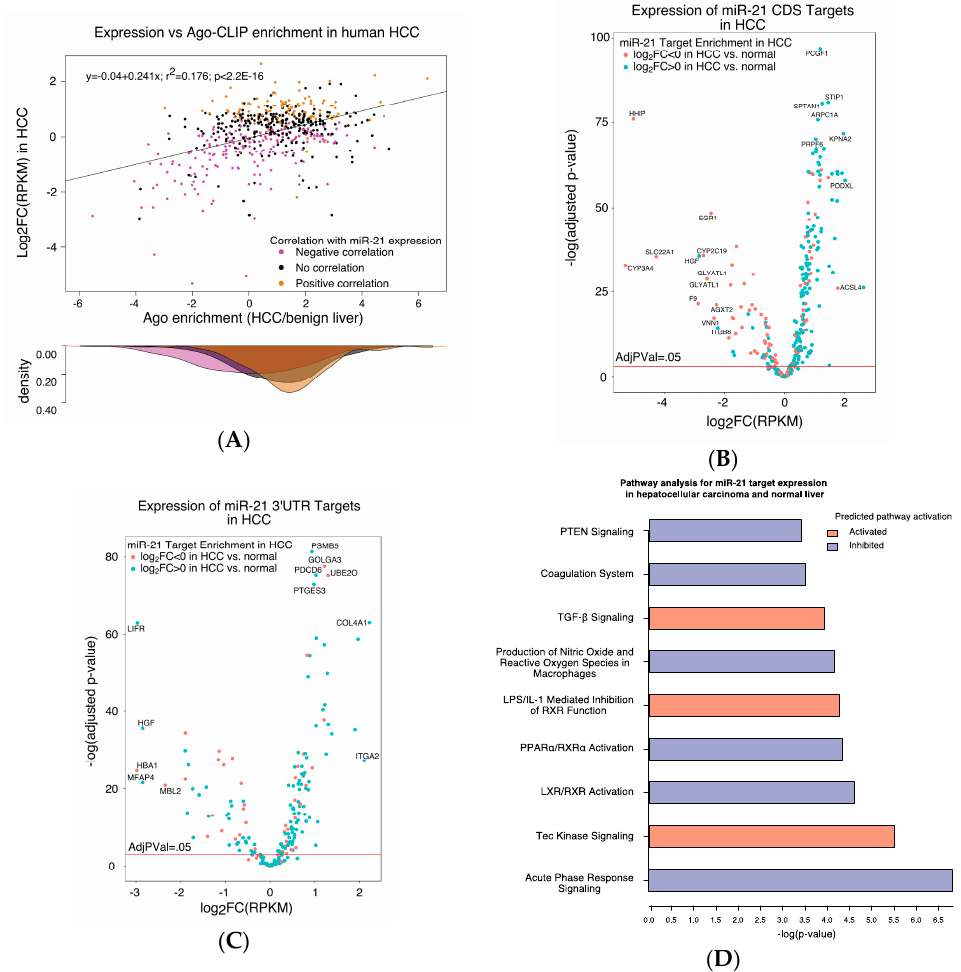
Figure 4. The expression data of the miR-21 interactome in tumor ( n = 377) and matched normal tissue ( n = 59) in patients with liver cancer were extracted from TCGA and compared to the tumor enrichment score determined by Ago-CLIP ( A ). Log 2 -fold enrichment of miR-21 targets by Ago-CLIP in HCC positively correlated with log 2 -fold expression change in tumor ( p < 2.2 × 10 − 16 ). Genes whose expression in tumors negatively correlated with miR-21 expression were less enriched in HCC by Ago-CLIP than those with positive correlation ( p < 2.2 × 10 − 16 ). Among miR-21 CDS targets, 64 genes were significantly downregulated and 173 genes were significantly upregulated ( B ). Among miR-21 3’UTR targets, 48 genes were significantly downregulated and 173 genes were significantly upregulated ( C ). Expression data for miR-21 targets in HCC were subjected to Ingenuity Pathway Analysis (IPA). Pathways predicted to be activated or inhibited by the miR-21 targetome are shown ( D ). Pathway significance was defined as having an adjusted p -value < 0.0005.